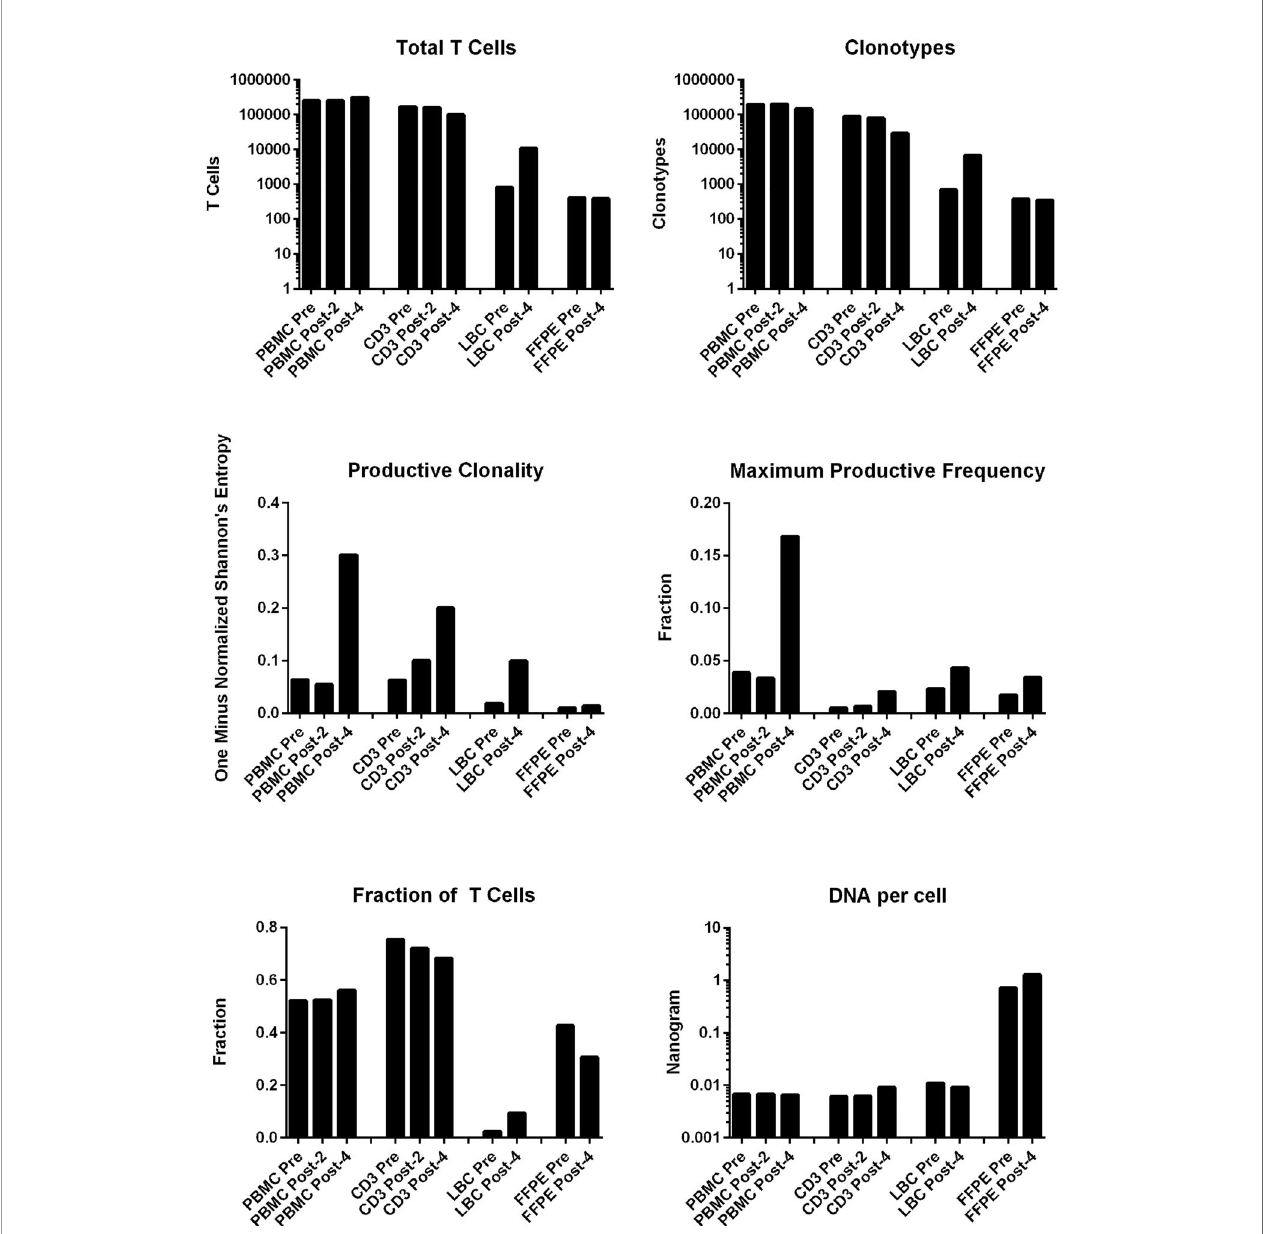
FIGURE 2 | T cell structures of PBMCs stimulated CD3+ T cells, LBC, and FFPE samples described with multiplexed PCR-based TCR sequencing using genomic DNA. The T cell structures of the 4 sample types (PBMCs, stimulated CD3+ T cells, LBC, and FFPE) are shown as the total number of T cells de fi ned by nucleotide sequence, productive clonality (one minus normalized Shannon ’ s entropy for all productive rearrangements), fraction of T cells (the number of productive templates divided by the number of nucleated cells), number of clonotypes de fi ned by nucleotide sequence, maximum productive frequency (the most frequent speci fi c productive rearrangement among all productive rearrangements within a sample), and the quantity of DNA (ng) per nucleated cell. The number of nucleated cells were determined using ampli fi cation of reference gene